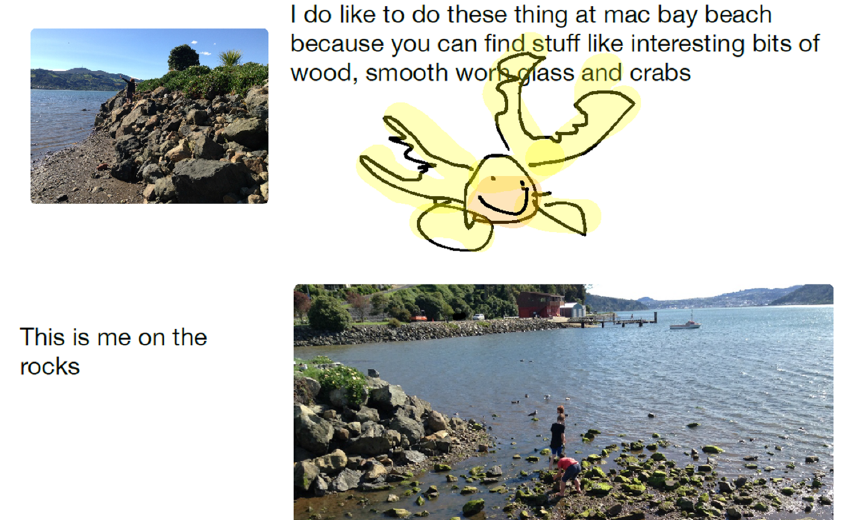
Figure 1. An excerpt of Tiki’s